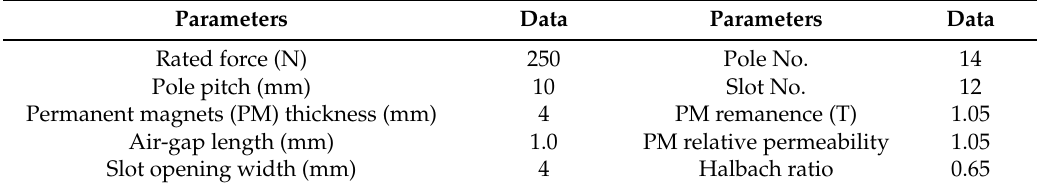
Table 1. Specification and Leading Design Parameters of a permanent magnet linear motor (PMLM).